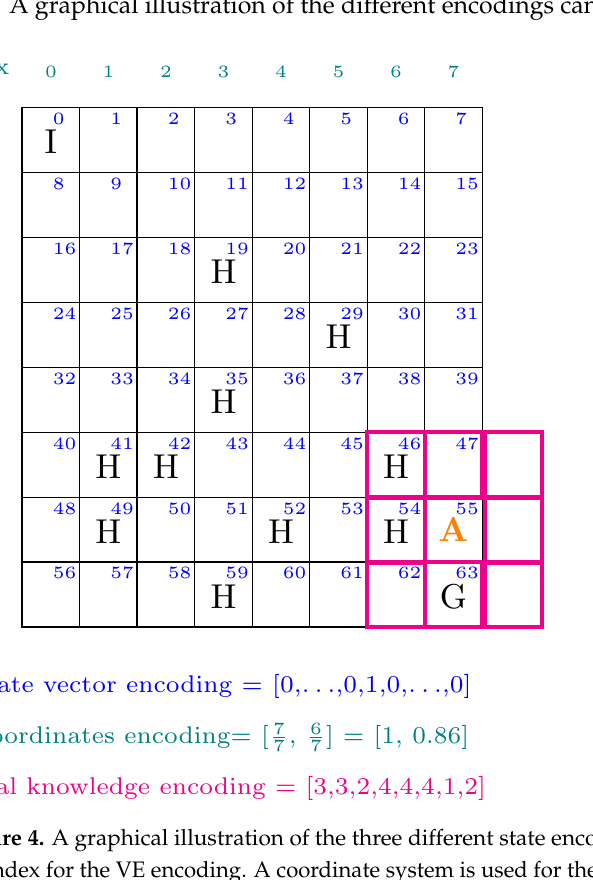
Figure 4. A graphical illustration of the three different state encodings. Every tile is represented by an index for the VE encoding. A coordinate system is used for the CE encoding and the surrounding 8 tiles represent the LKE encoding. An example for the state A is given for every encoding in the